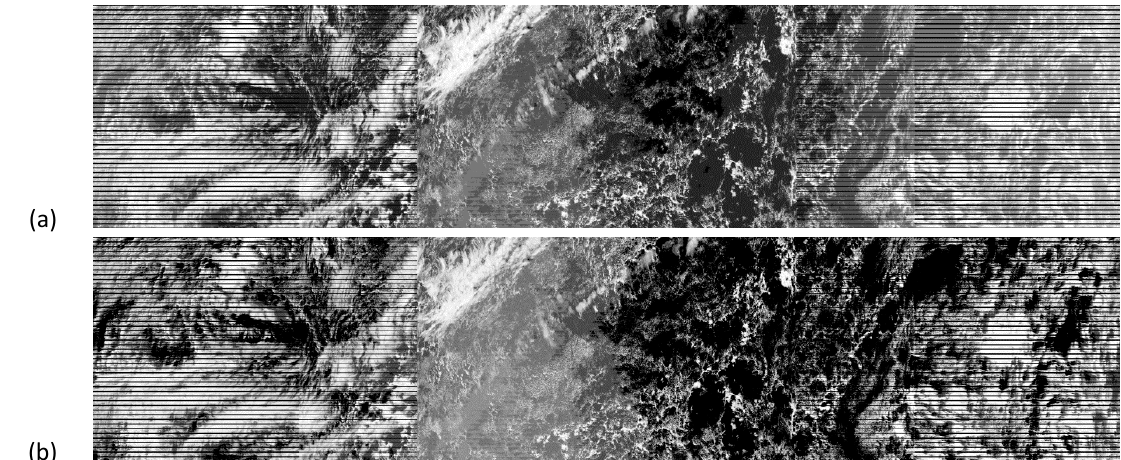
Figure 3. VIIRS imagery collected at 1612 UTC on 20 Feb 2014 over the north Atlantic Ocean. ( a ) of the M5 (672 nm) band shows blurred features toward the edges of scan, while sunglint blurs features near the middle of the image. ( b ) of the M10 (1610 nm) band shows sharper features and improved cloud to background contrast in water clouds located toward the edges of scan due to reduced path radiance and molecular scattering.